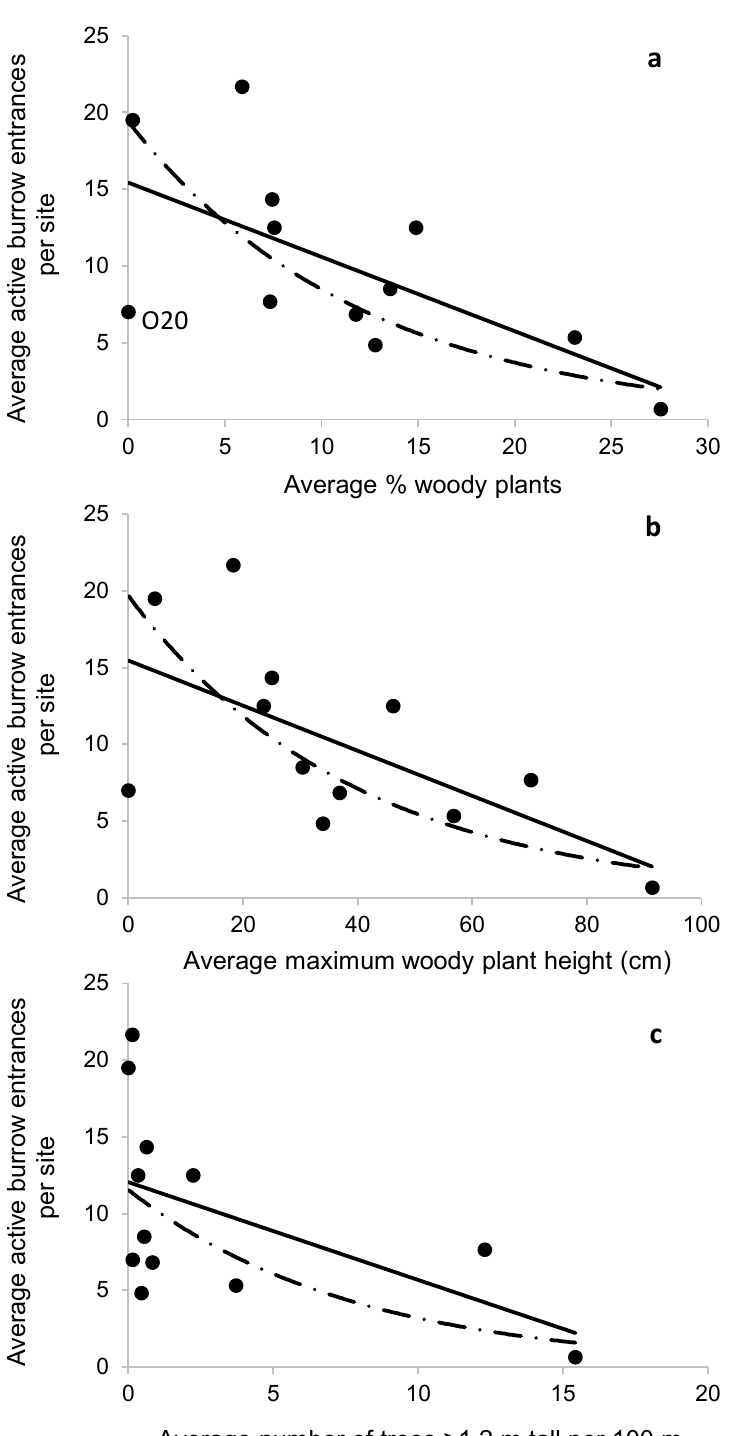
Figure 5. The average number of active burrow openings per site versus the three most informative habitat variables: average percentage of each quadrat covered by woody vegetation ( a ), average maximum woody plant height ( b ), and average number of trees taller than 1.2 m per 100 m of transect length ( c ). Linear and exponential curves shown.